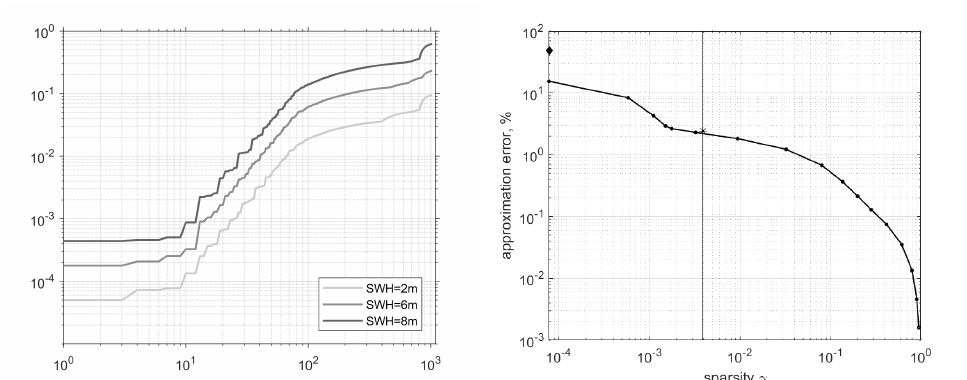
Figure 2. ( Left ) Eigenvalues of the expansion matrix in Equation (10) computed for three different values of SWH field at 2 km resolution. ( Right ) Dependence of the precision matrix approximation error on the fraction γ of non-zero elements in a matrix. Consecutive (from left to right) dots along the graph correspond to two-time reduction of the threshold value eliminating small matrix elements to obtain an approximation. Thin vertical line corresponds to sparsity of the block-diagonal approximation. Diamond and asterisk mark approximation errors obtained, respectively, by inverting the diagonal of R , and keeping only block-diagonal elements of the precision